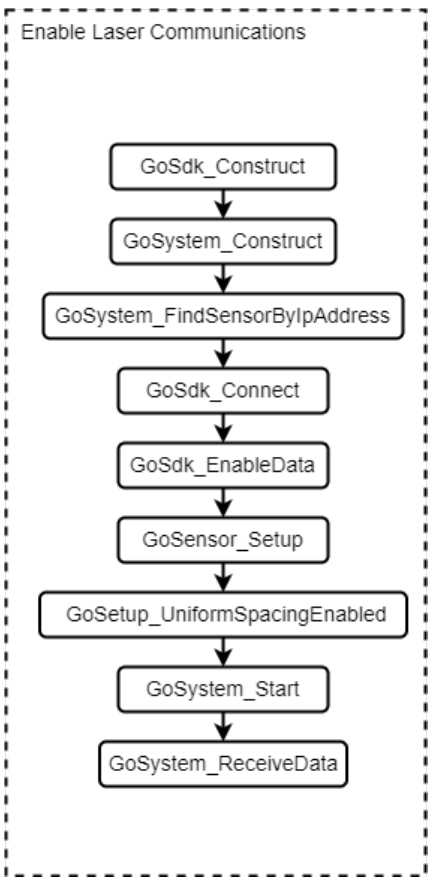
Figure 10. Libraryfunctions algorithm.